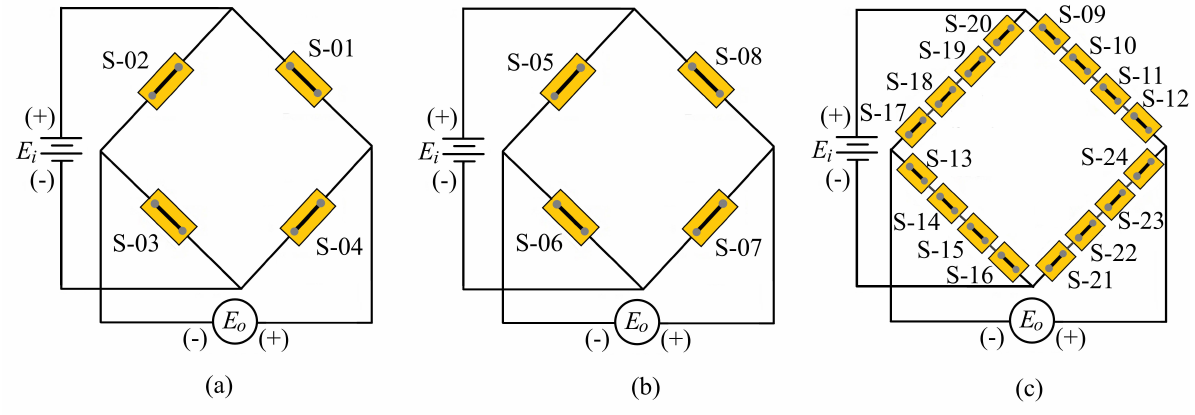
Figure 7. Wheatstone bridge circuits for detection of forces in cross-beam force transducer: ( a ) F x ; ( b ) F y ; ( c ) F z